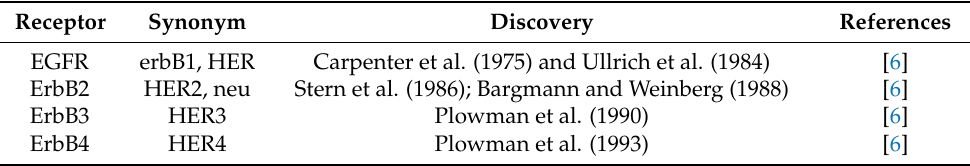
Table 1. The synonym and discovery of four members of the EGFR